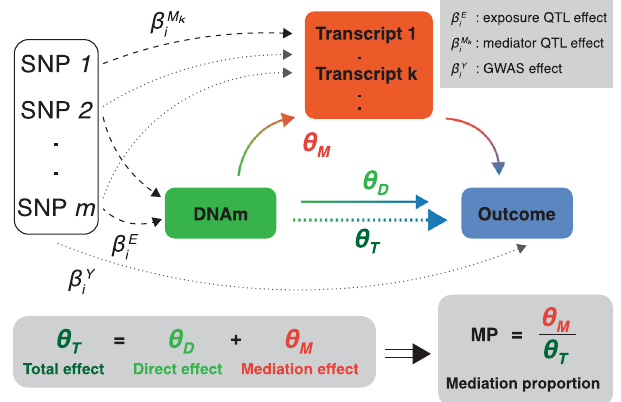
Fig. 1 | Overview of the three-sample multivariable Mendelian randomization (3S-MVMR) design to quantify mediation of complex traits through DNA methylation(DNAm)andtranscripts. Geneticinstruments(SNPs)areselectedto be directly and signi fi cantly associated (dashed arrows) with either the exposure (DNAm, green) or any mediator k (transcript in cis , red). The total effect θ T (green- blue dotted arrow) of the exposure on the outcome (complex trait, blue) is esti- mated in a univariable MR analysis based on exposure-associated SNPs only. The direct effect θ D (green-blue arrow) is estimated in an MVMR analysis on all valid instruments. The mediationeffect θ M (green-red and red-blue arrows)results from thedifferencebetween θ T and θ D ,andallowstocalculatethemediationproportion (MP).Thegeneticeffectsizes β ontheexposure,mediatorandoutcomecomefrom m/eQTL and GWAS summary statistics, respectively. Transcripts were required to be causally associated to the DNAm-exposure to be included as